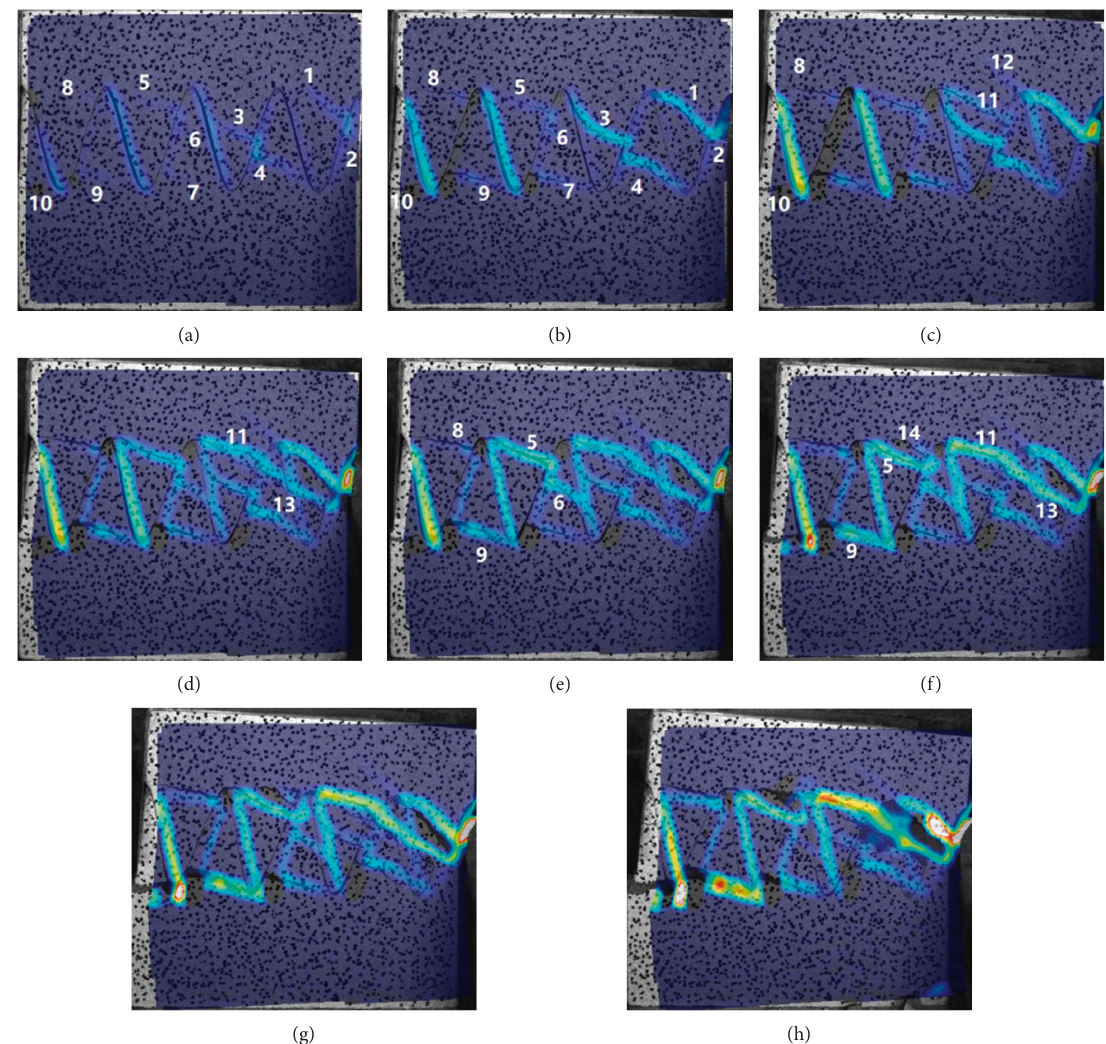
Figure 11: Failure process of the specimen with an undulated height of 30mm under DIC